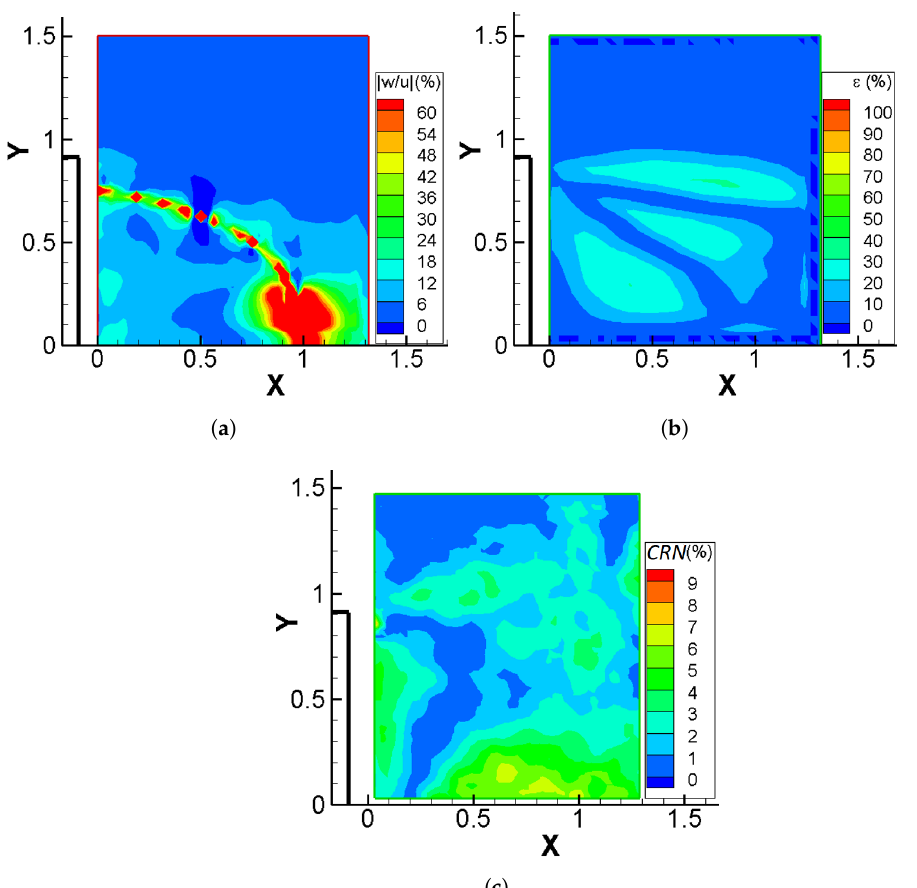
Figure 15. Contours of: ( a ) the absolute value of the fraction of the third velocity component w over the u velocity component (acquired through stereo-PIV), | w / u | %, on plane C, ( b ) the difference between the CFD estimate of the total velocity and that of the PIV method, (cid:101) ( % ) , on plane C, ( c ) the non-dimensional continuity residual, CRN ( % ) , for the PIV results on plane C. The solid boundary of the cube is denoted by the thick black line, while X and Y are non-dimensional coordinates. Flow is from left to